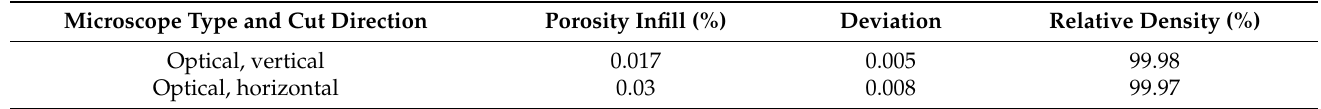
Figure 2. Relative density over the surface-to-volume ratio. Table 6. Infill porosity for vertical and horizontal cuts measured by optical